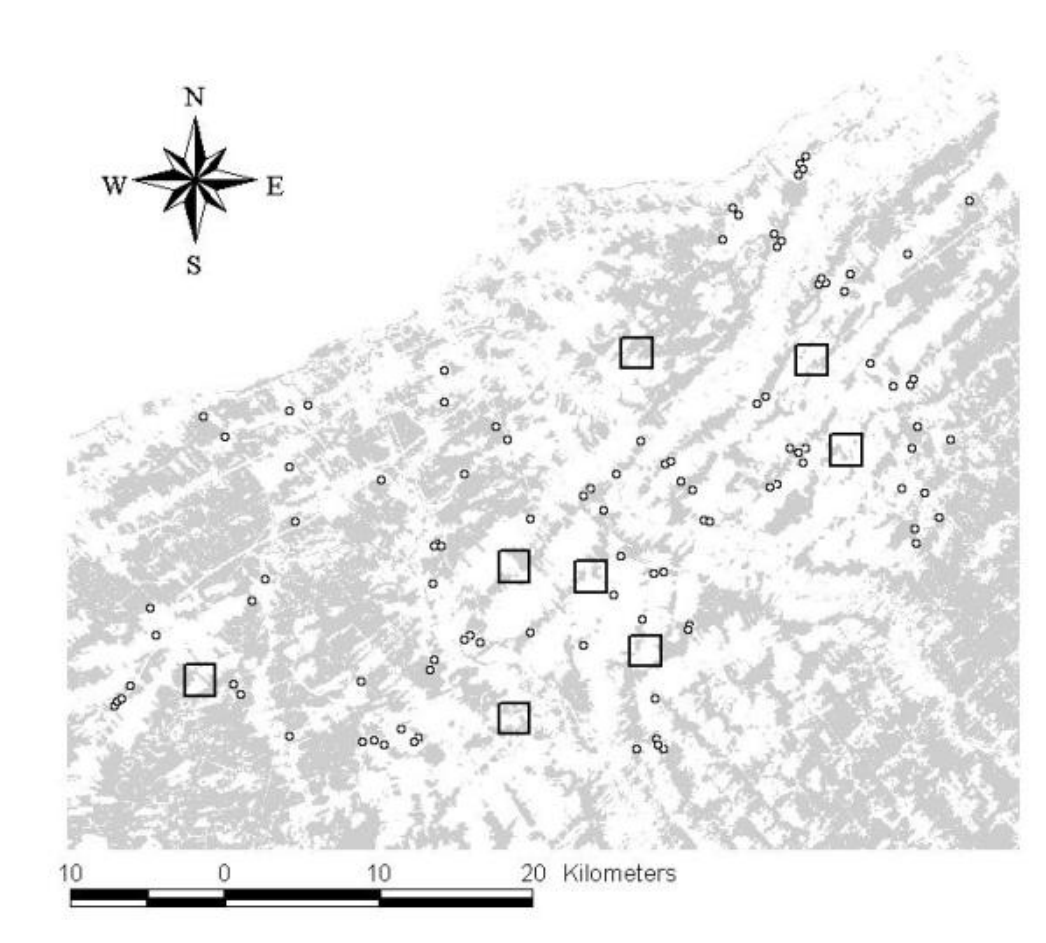
Fig. 1. Layout of 102 point count stations and eight plots over a classified satellite image. Sites are located within 50 km of Quebec City (46°45’ N, 71°20’ W), Québec, Canada. Mature forest is represented by the grey areas, whereas the white areas represent all other types of habitat, e.g., agricultural fields, roads, human settlements, bodies of